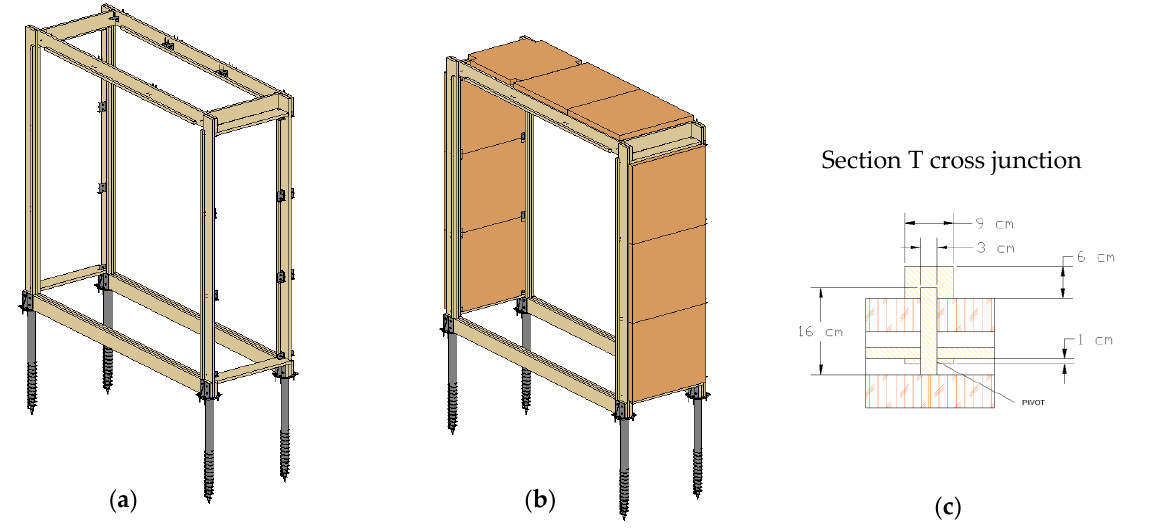
Figure 2. Modular element of the proposed THU: support frame ( a ). Assembled module “M” ( b ). Junction section ( c ).